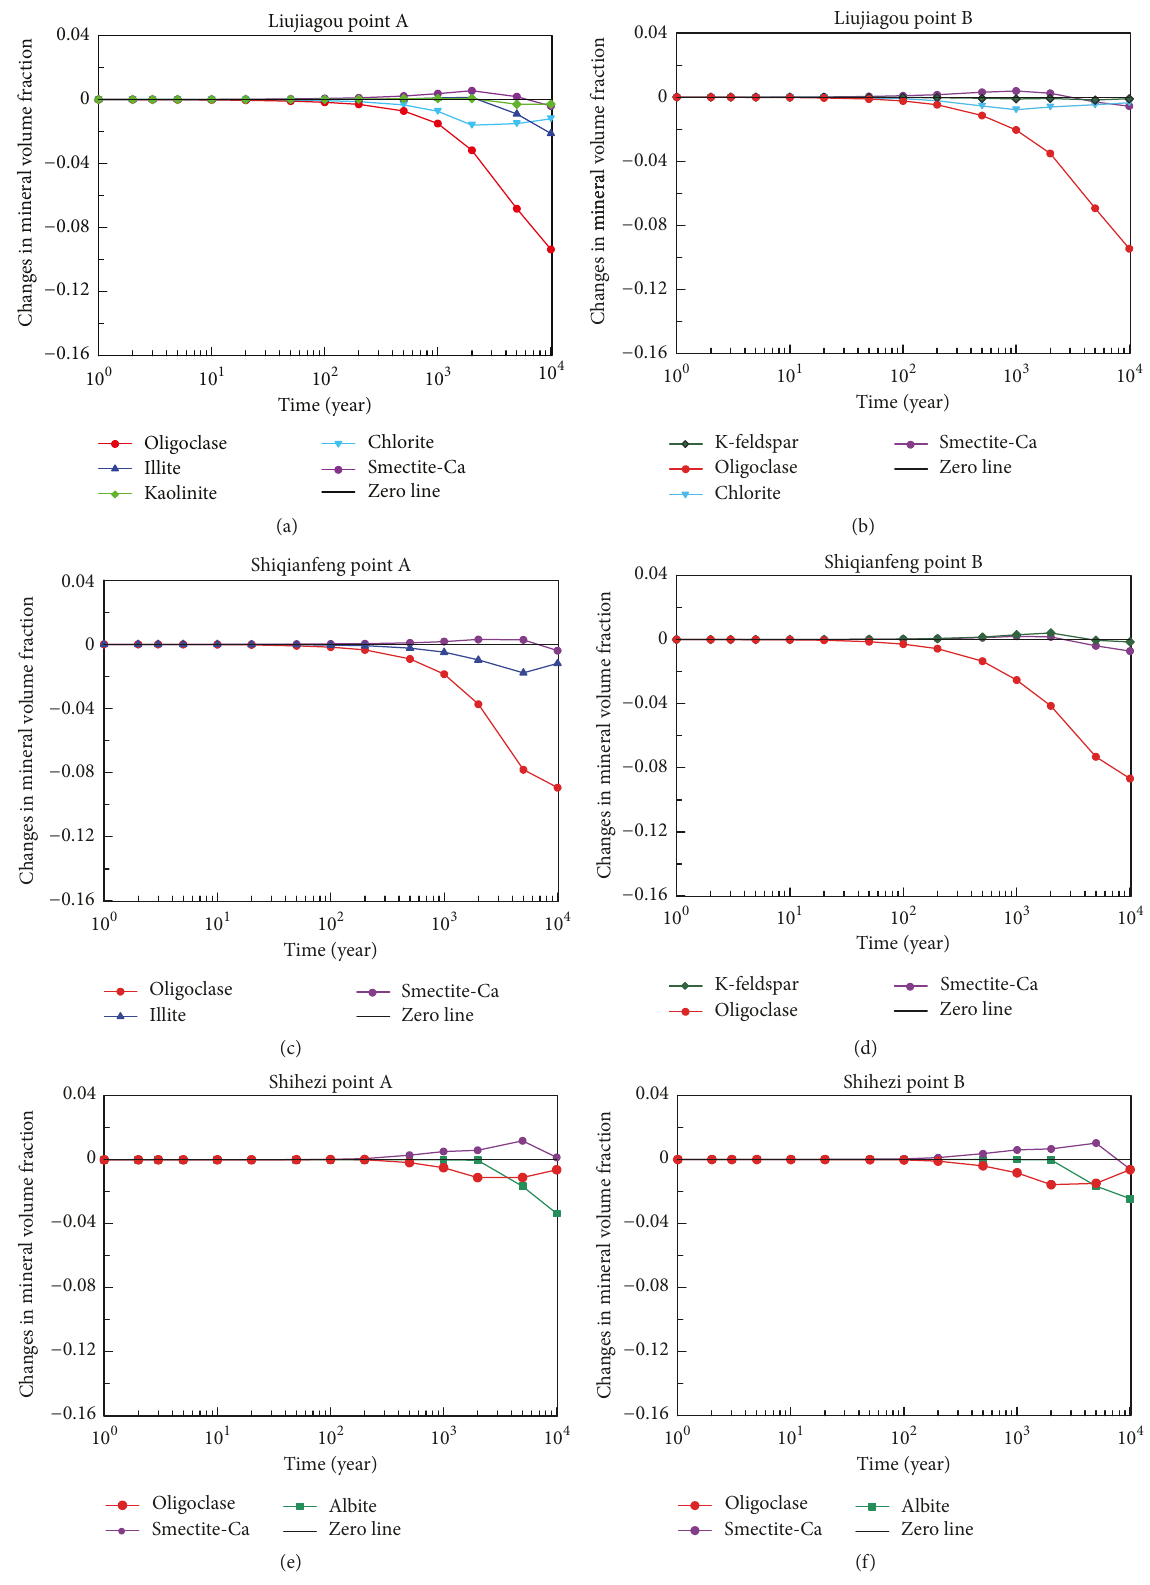
Figure 7: The evolution of dissolved minerals at points A and B for the Liujiagou formation (a, b), Shiqianfeng formation (c, d), and Shihezi formation (e, f) over